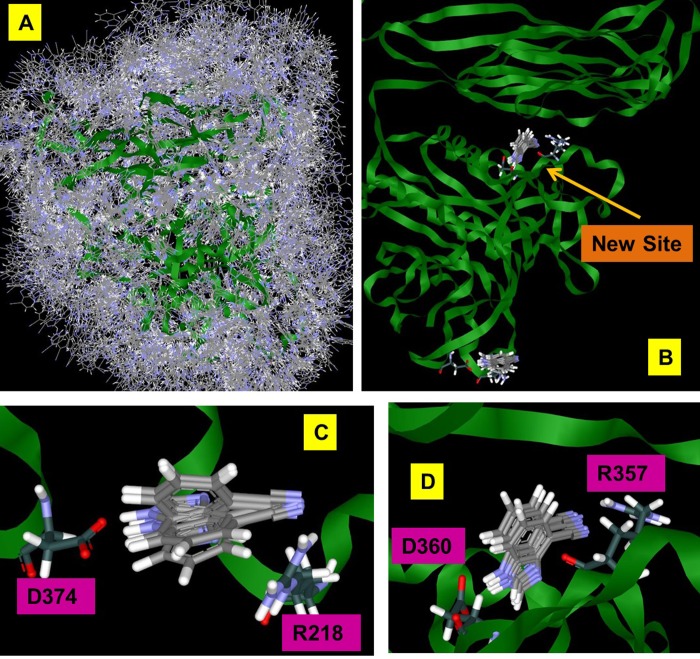
SACP on PCSK9 with cyano-benzimidazole.The high chemical potential (A) and lowest chemical potential (B) simulations identify the known high affinity (C) Y306 LDLR binding site and a (D) new site.